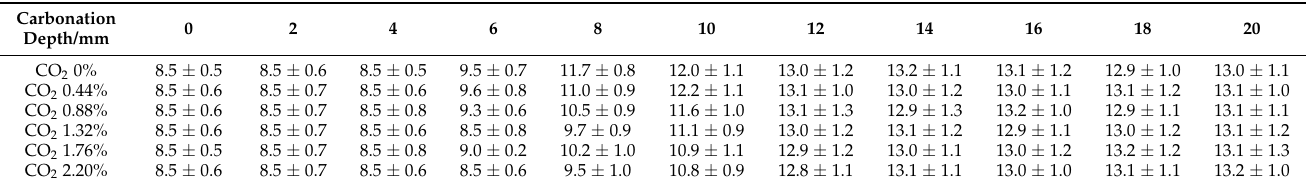
Table 5. pH value at 28 d in carbonized area of cement mortar with different CO 2 absorption (mechanical